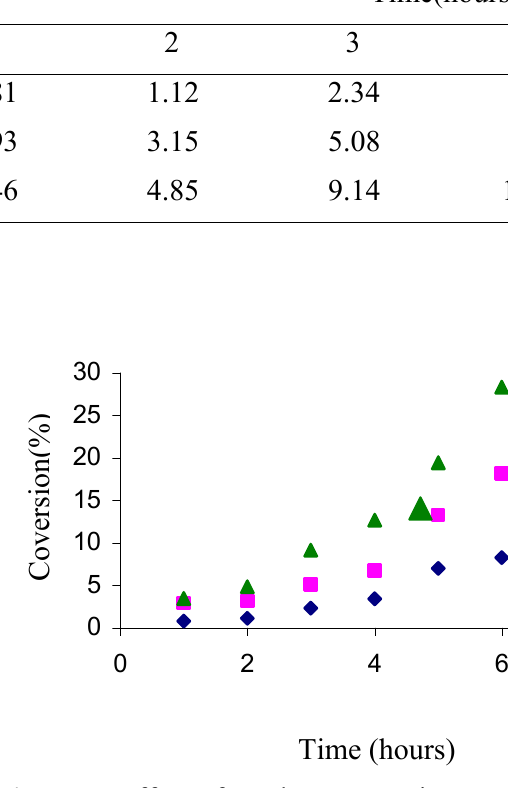
Figure 5. Effect of catalyst proportion upon the